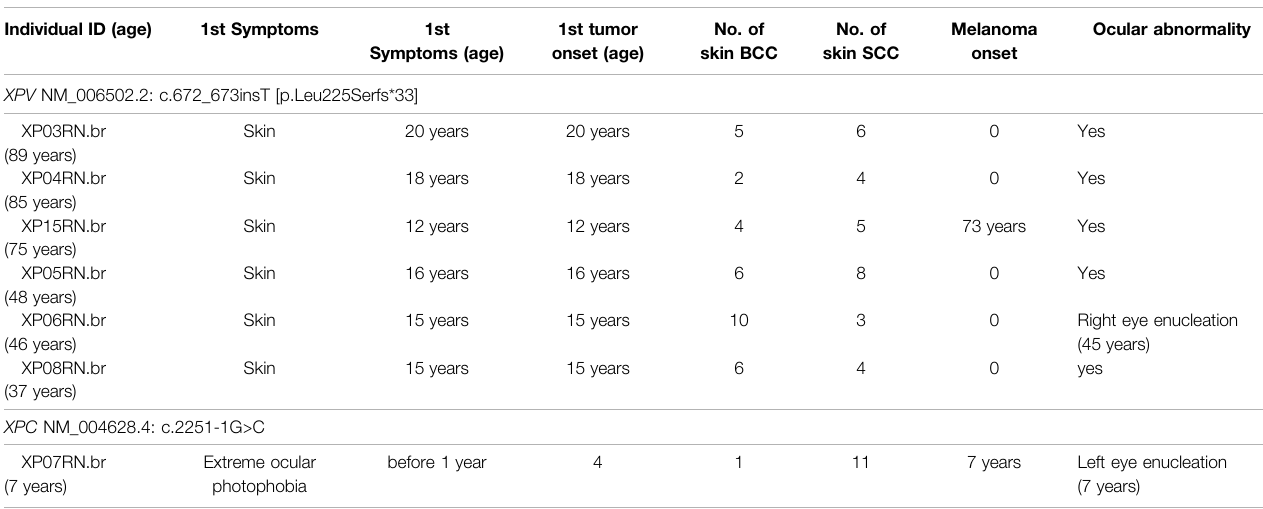
TABLE 2 | Clinical symptoms from the XP-V and XP-C patients from Montanhas (RN). Individual ID (age) 1st Symptoms 1st